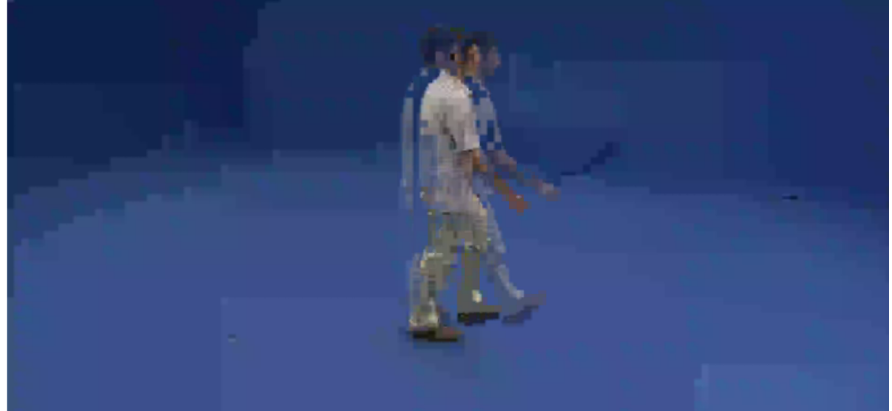
Figure 9. Frame of a video with a bitrate of 70 Kbps: Accuracy =